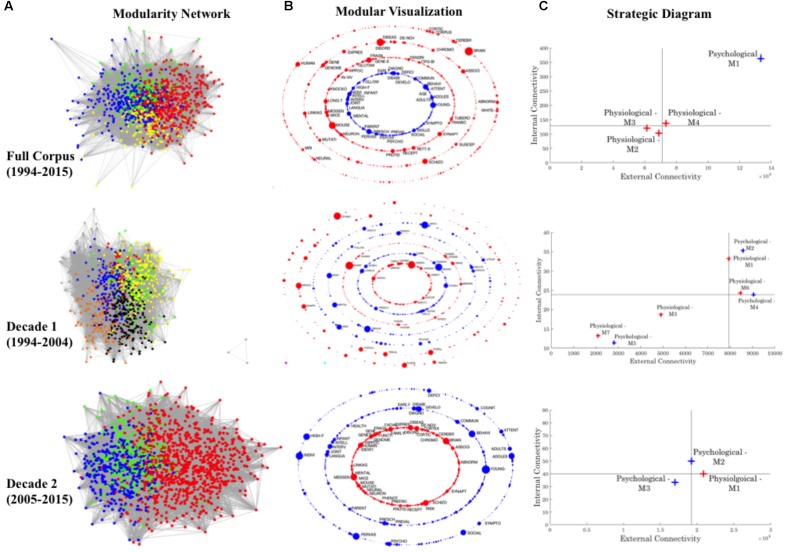
(A) Refinement of the network after the removal of core network hubs to assess the stability of network clusters and modularity at all levels of examination. As demonstrated in (B), these are classified into Psychological, or Physiological focus based upon core internal nodes. This categorization is color coded (Psychological: Blue; Physiological: Red, Green: Interdisciplinary), with the order of concentric rings reflecting each module’s rank. In addition, this corpus was systematically deconstructed to consider patterns across two individual decades (Decade 1: 1994–2004 and Decade 2: 2005–2015), and internal and external connectivity metrics (C). Intuitively, the removal of network hubs leads to reduced levels of overarching median normalized external and internal connectivity at all levels. See Supplementary Table 4 for comparisons. For larger high resolution figures please see https://figshare.com/s/7f723b2c983a747f7e44.